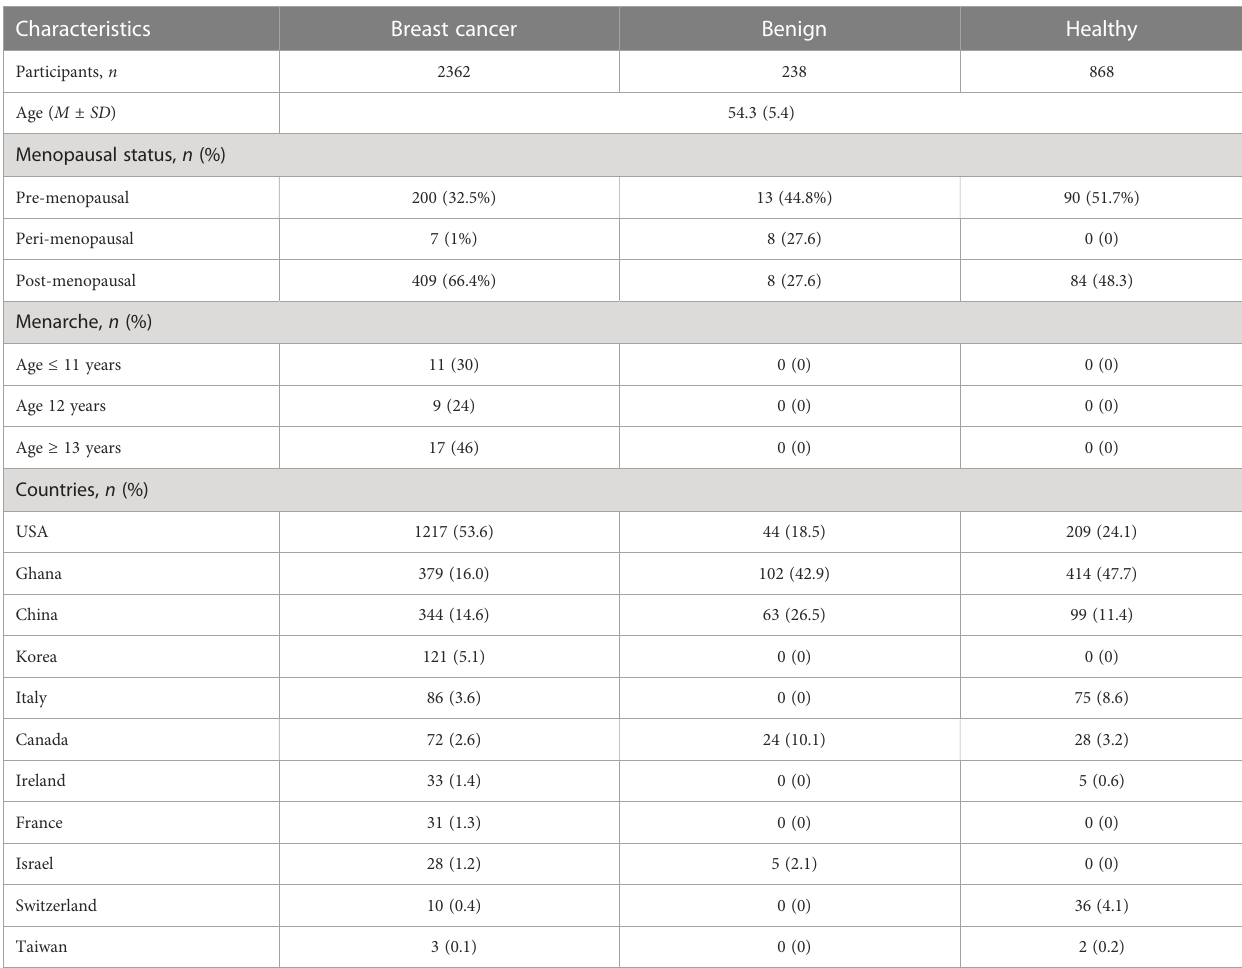
TABLE 2 Demographic characteristics of participants.